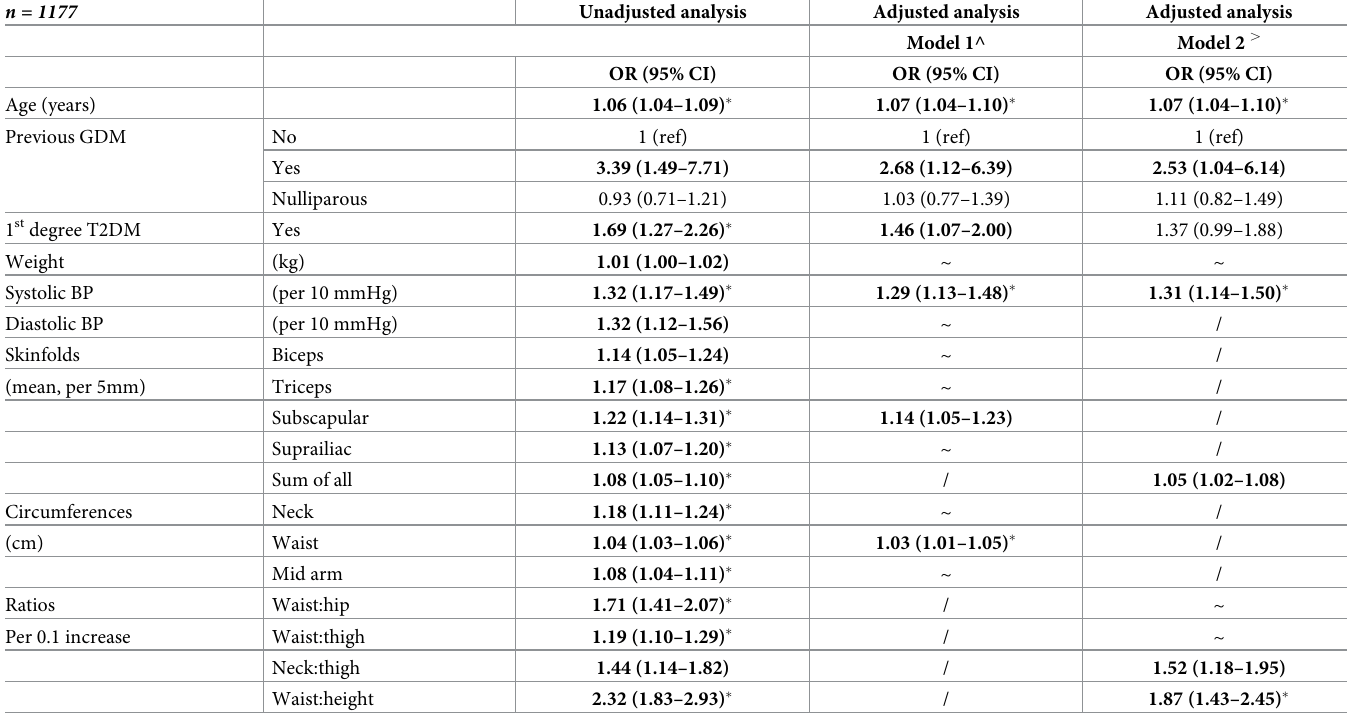
Table 5. Clinical history, and clinical and anthropometric variables measured at 27 +5 weeks’ (mean) gestation associated with GDM diagnosis; unadjusted and mul- tiple regression analyses. n =